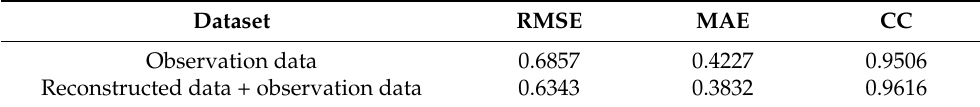
Table 2. The effect of adding reconstruction data during model training.